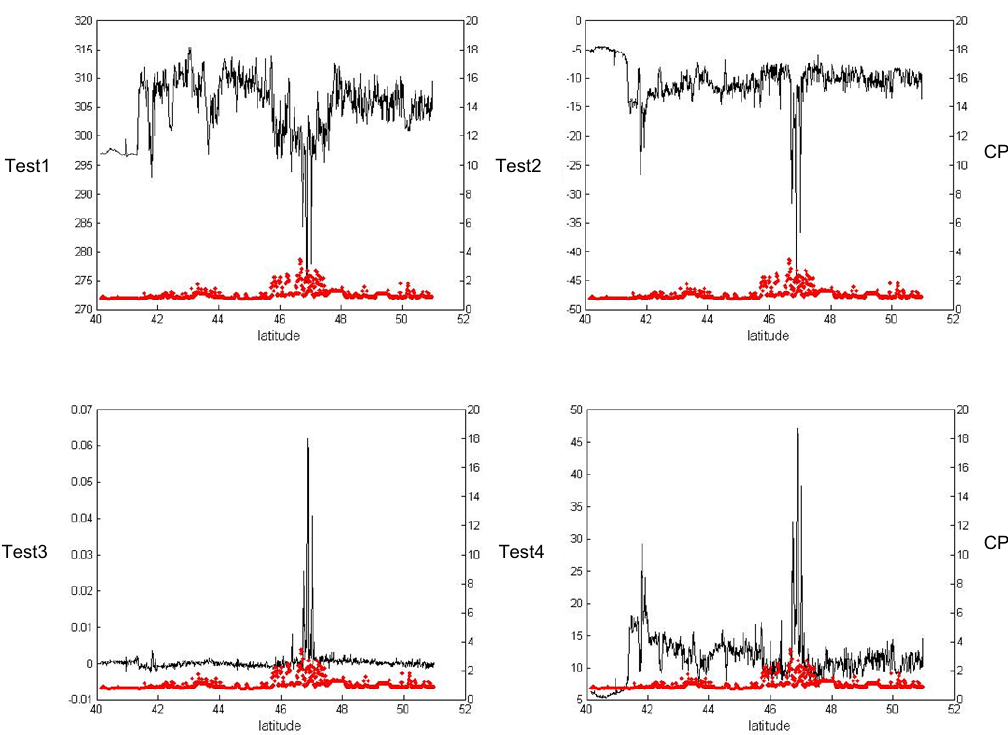
Figure 2. Comparison among the geo-located profiles of the different tests on MODIS data (black line) and the cloud profiles (CP) detected by CloudSat (red line). The data correspond to DOY 200 in 2006 when the sky was almost completely cloud-free.